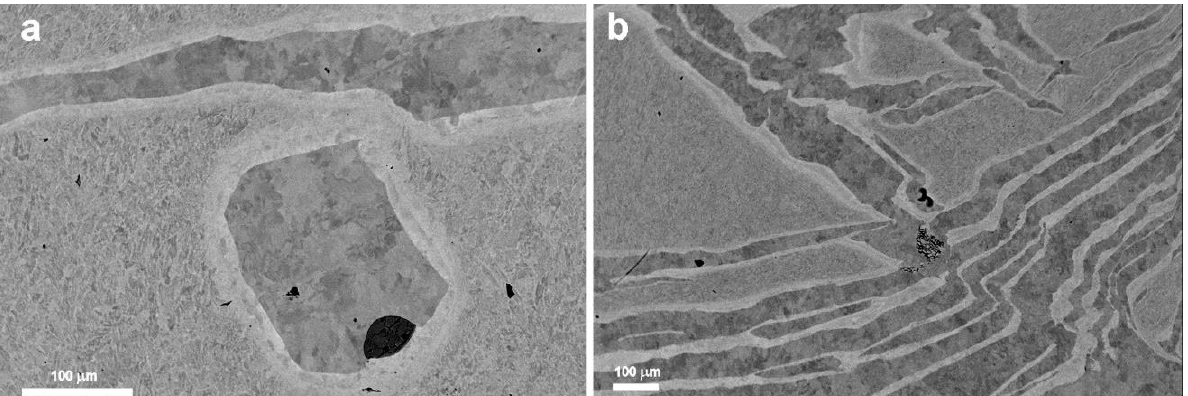
Figure 5. SEM-BSE image of two areas of a polished sample of the Oglat Sidi Ali meteorite; dark grey is kamacite; pale grey is taenite and Ni-rich taenite; medium grey is a plessitic texture; black areas are troilite ( a ) and nickel-phosphide ( b ).